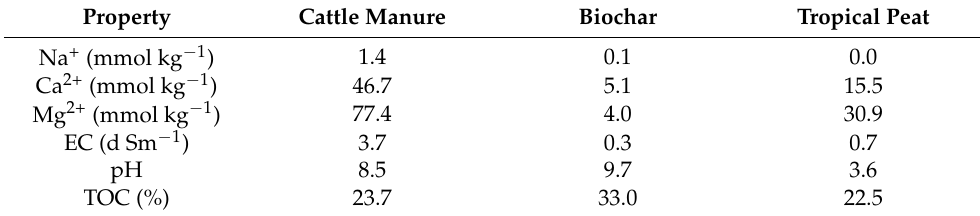
Table 2. Some chemical properties and TOC of the organic amendments. Property Cattle